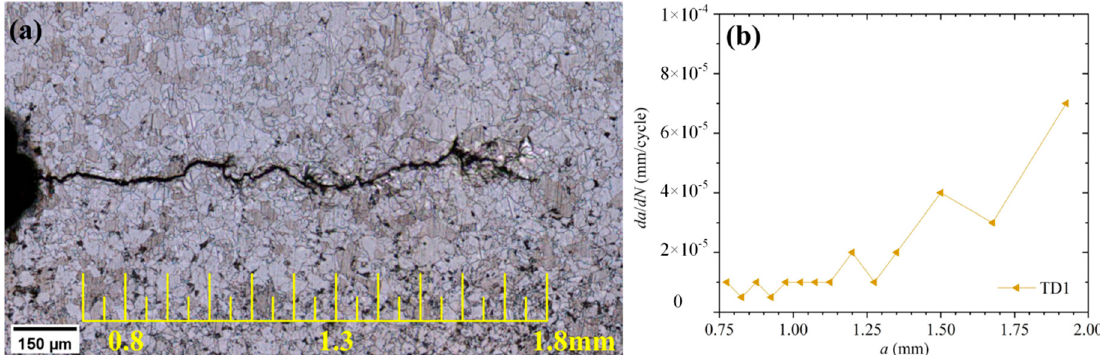
Figure 6. ( a ) The crack growth path of the TD1 specimen; ( b ) da/dN-a curve of the TD1 specimen.